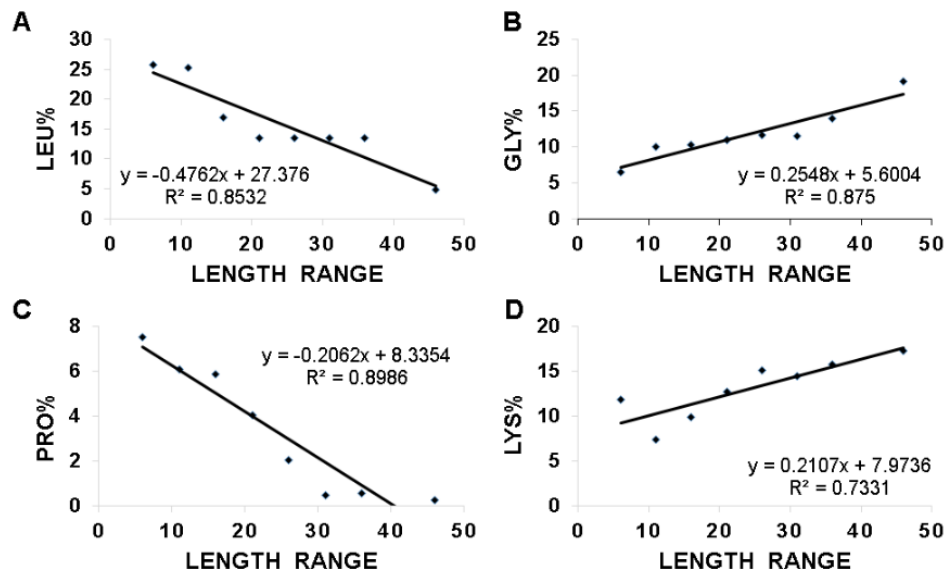
Figure 6. Relationships between peptide length and the average amino acid content of leucine ( A ); glycine ( B ); proline ( C ); and lysine ( D ) based on the data in the APD as of 29 June 2020. The 1015 frog antimicrobial peptides were split into various groups at a length step size of 5: 6–10, 11–15, 16–20, 21–25, 26-30, 31–35, 36–40, 41–45, and 46–50 amino acids. The number of peptides in each group varies from 10 to 325. The length group 41–45 was not included in this plot due to a small number of only four members and the existence of the only two frog defensins. Data from the APD as of June 2020 [78]. Table 4. Amino acid use in dermaseptins depends on peptide length 1.